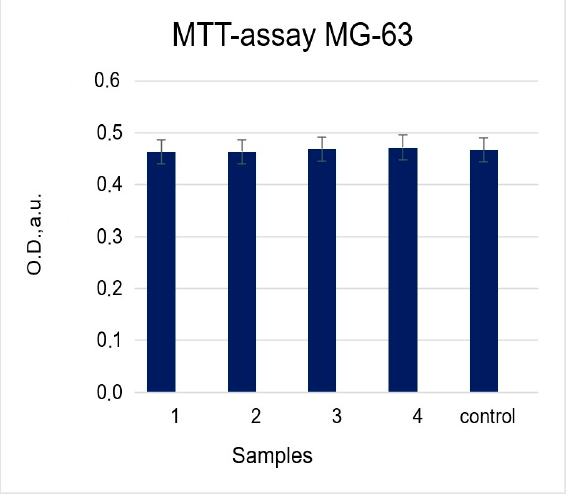
Figure 8. Proliferation activity of MG-63 cells on the samples.